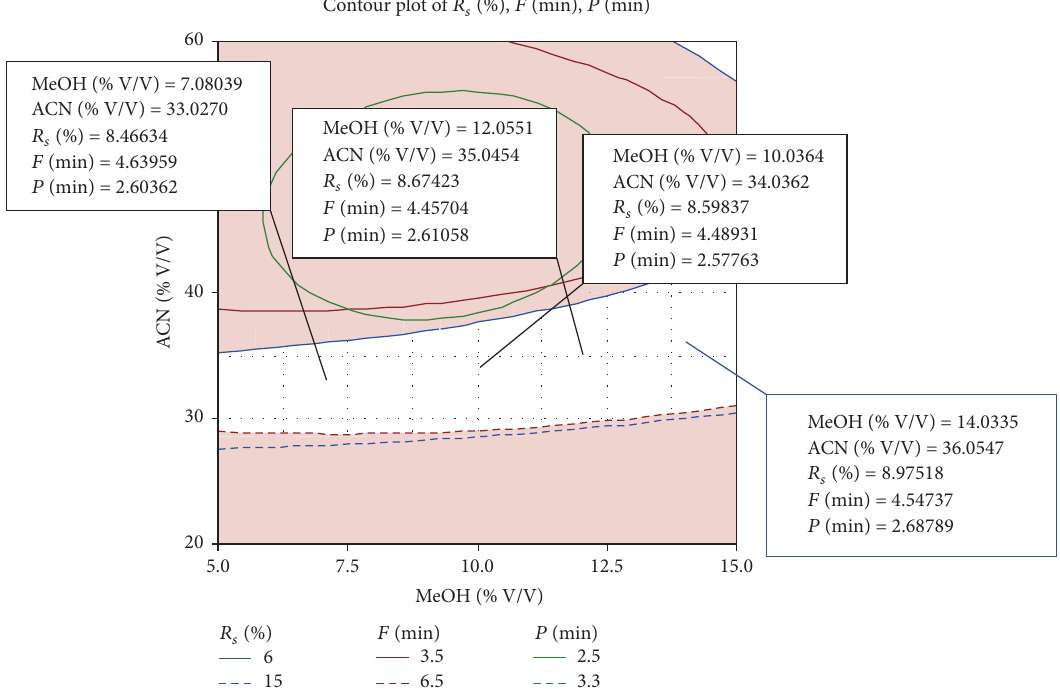
Figure 3: Overlaid contour plot of the responses and the design space: 𝐹 (min) and 𝑃 (min) are the retention time of FEX and PSU in minute. Solid lines indicated the desired lower limit and broken lines indicated the desired upper limit of each response.